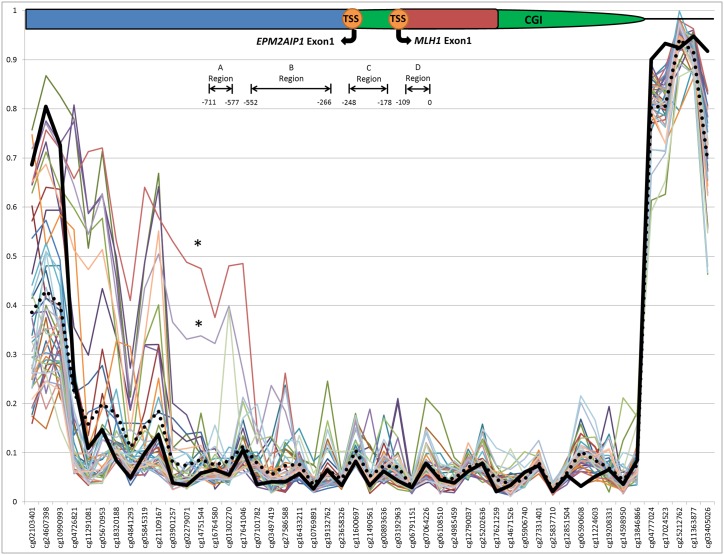
Sample tumor DNA methylation at the MLH1 promoter region.Plotted β-values for each sample at each CpG probe across MLH1 (chr3:37,033,277 –chr3:37,082,650). Solid black line indicates average β-values for blood-derived DNA. Dotted black line indicates average β-values for tumor-derived DNA. Schematic of four MLH1 promoter regions previously defined by Deng et al, base pair number is in relation to the start codon (ATG) Regions. * highlights tumor-derived DNA samples showing increased MLH1 methylation. Gene region schematic denotes [CGI (CpG Island), TSS (Transcriptional Start Site)]